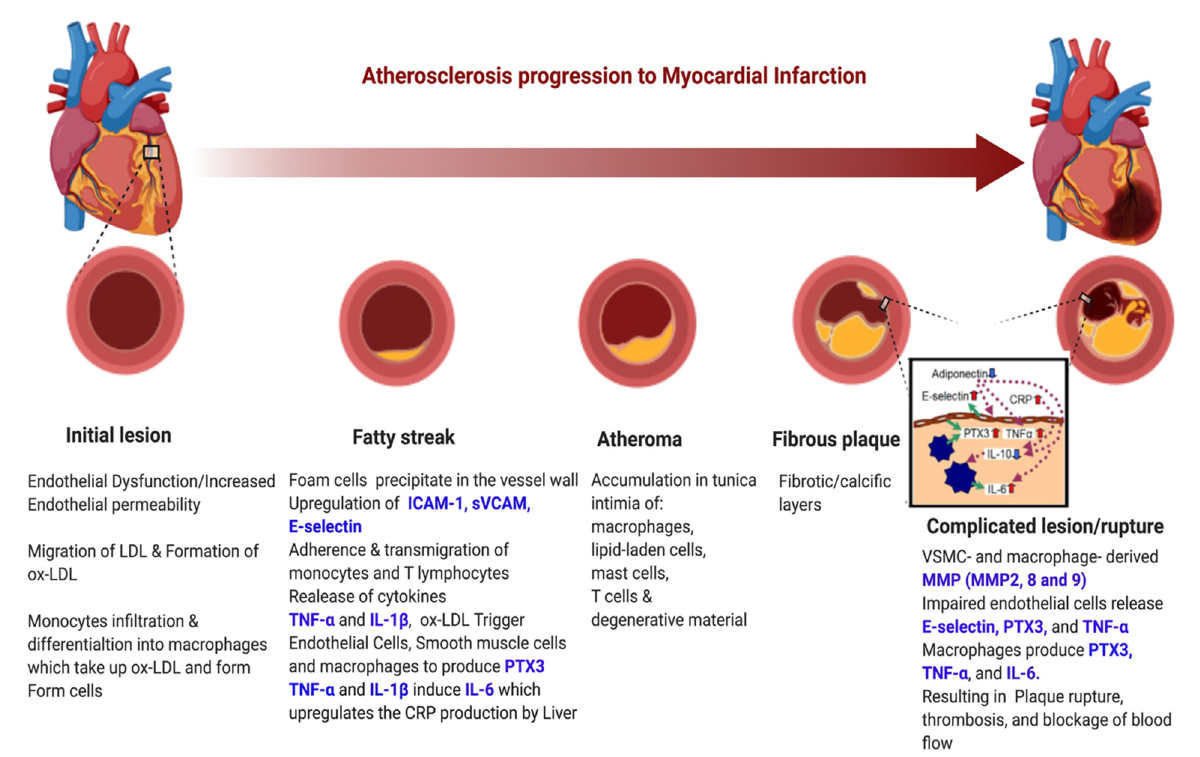
Figure 3. Atherosclerosis progression process. (Figure created using Biorender.com) (accessed on 16 June 2022).